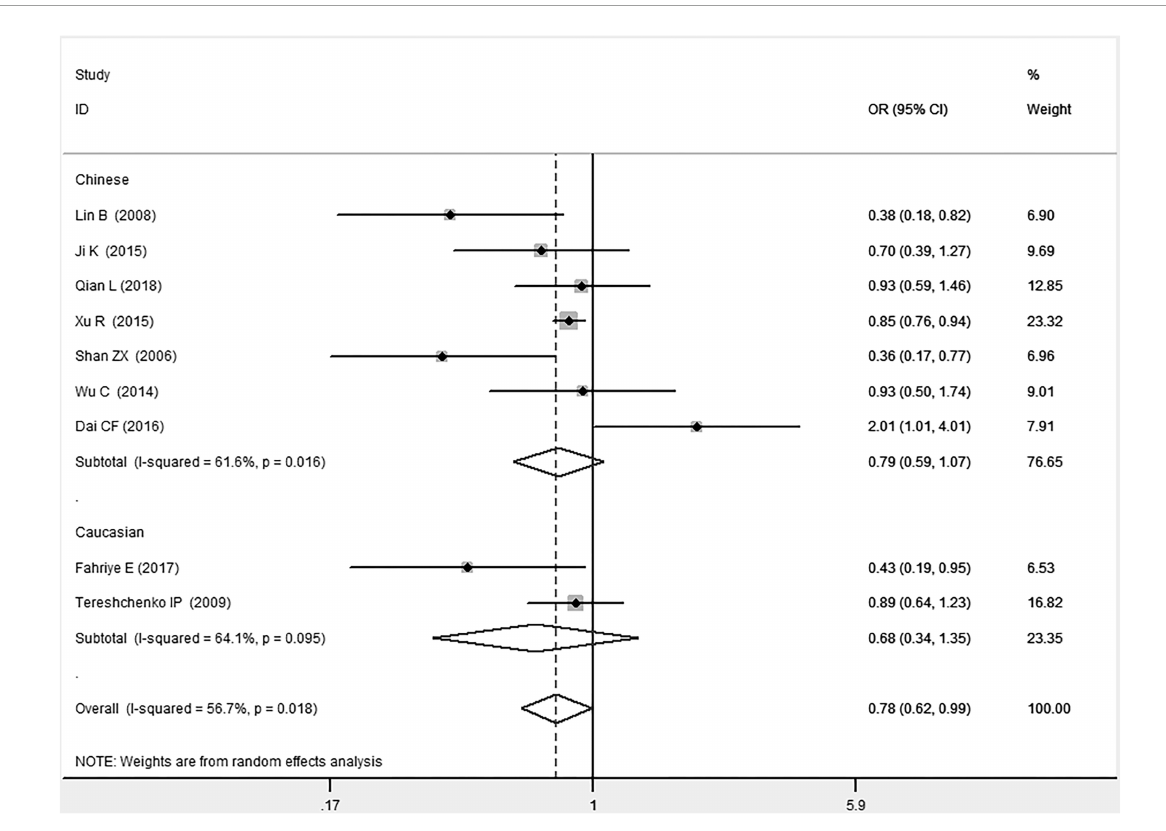
reflected 2 articles and 905 participants. In the